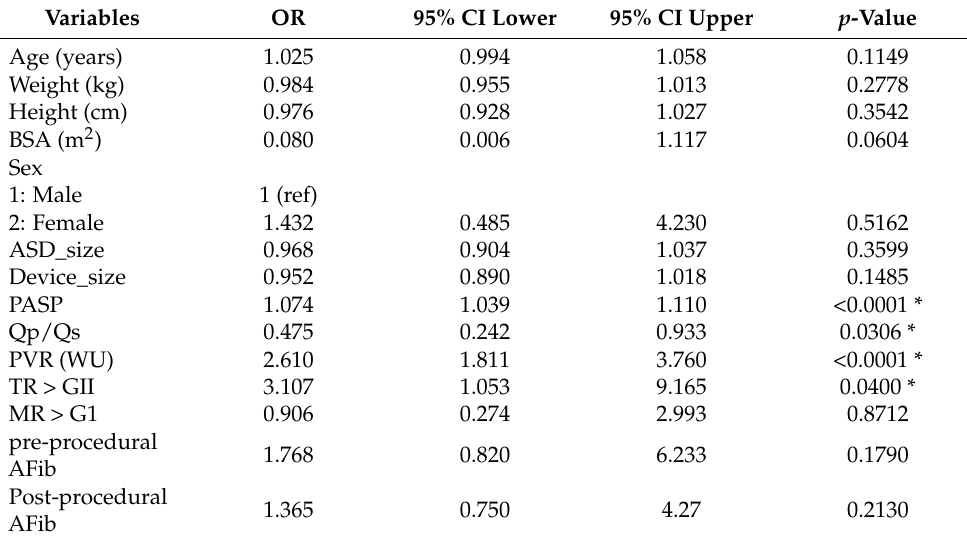
Table 4. Univariate analysis for rPAH post-tcASD.